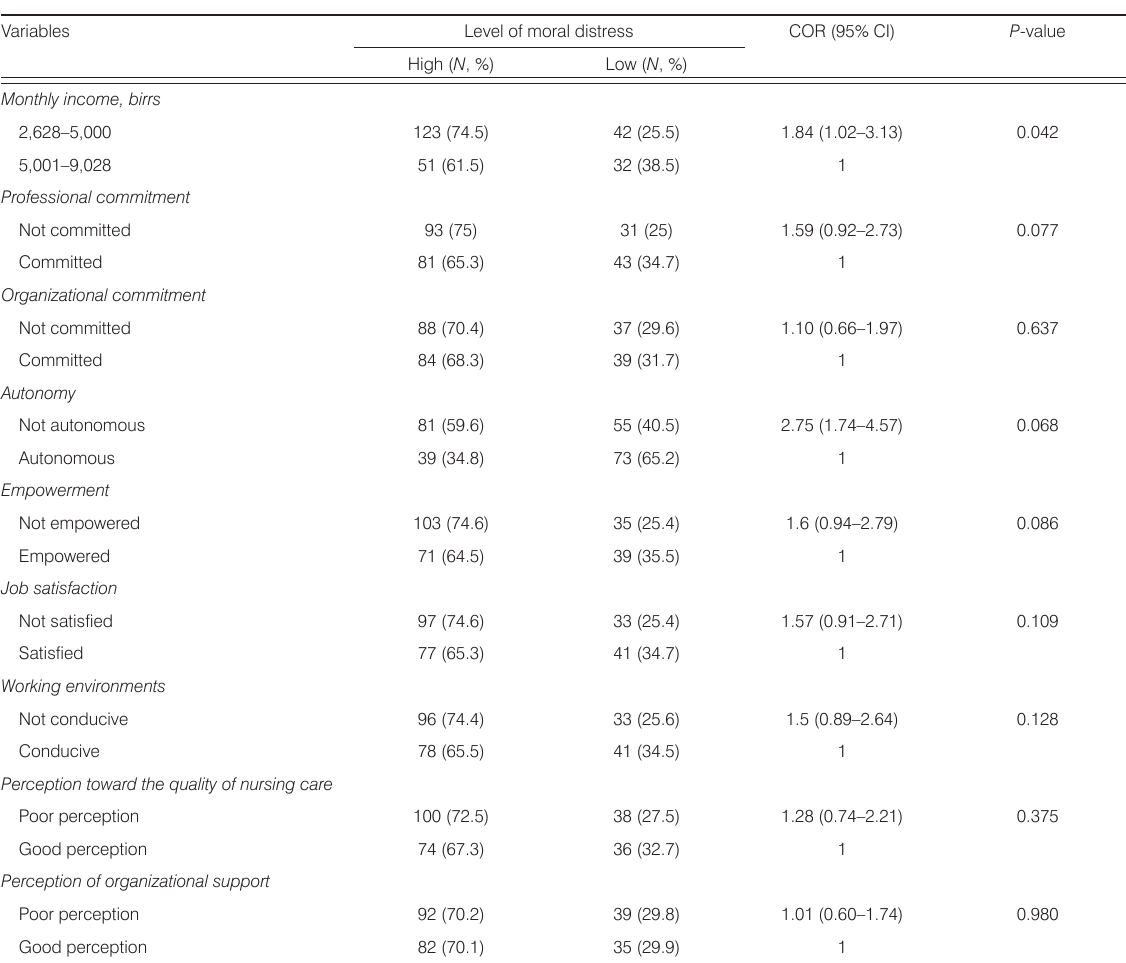
Table 2. Bivariate analysis of socio-demographic variables among nurses working at Jimma University Medical Center, Jimma Zone, Jimma Town, South West Ethiopia, April 2019 ( n = 248).